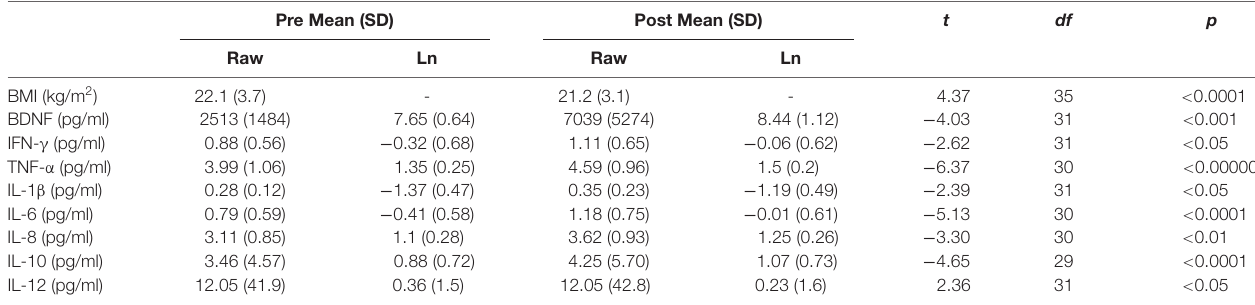
TABLE 3 | Biomarkers pre- and